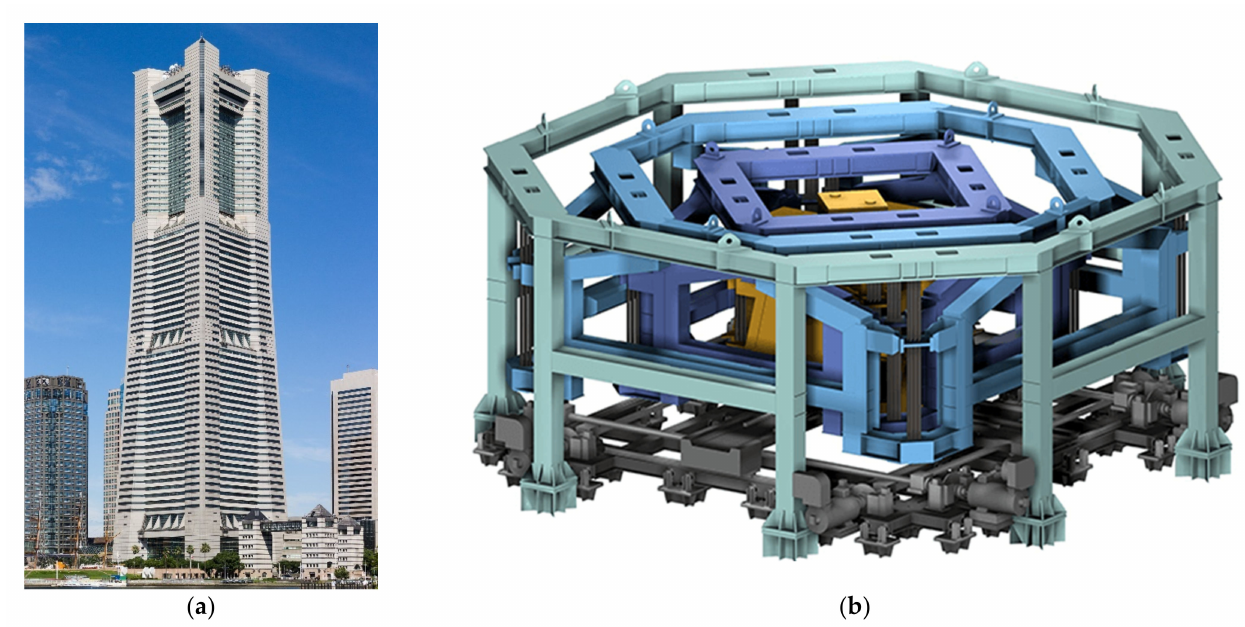
Figure 24. ( a ) Landmark Tower in Yokohama equipped with tow HMDs https://upload.wikimedia.